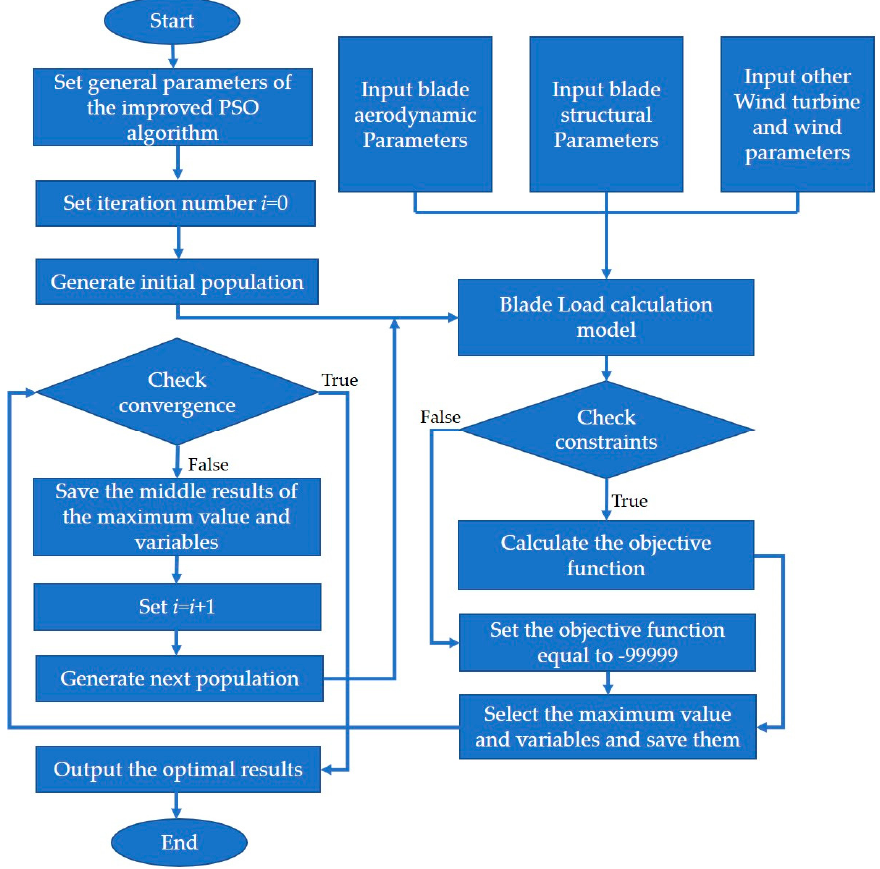
Figure 7. Flow chart of the particle swarm optimization-extreme load prediction model (PSO- ELPM).